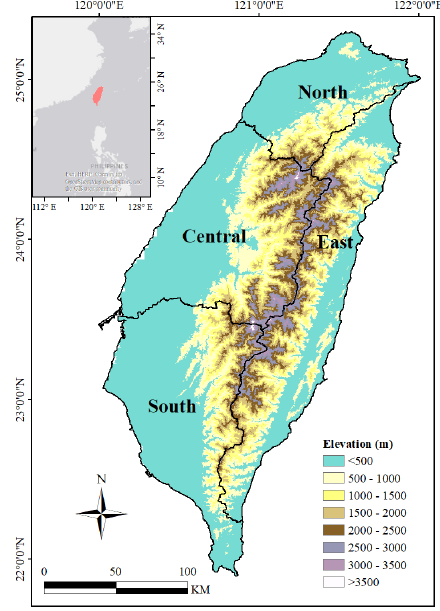
Figure 1. Study Figure 1. Study area. Table 1. Regional counties and cities.